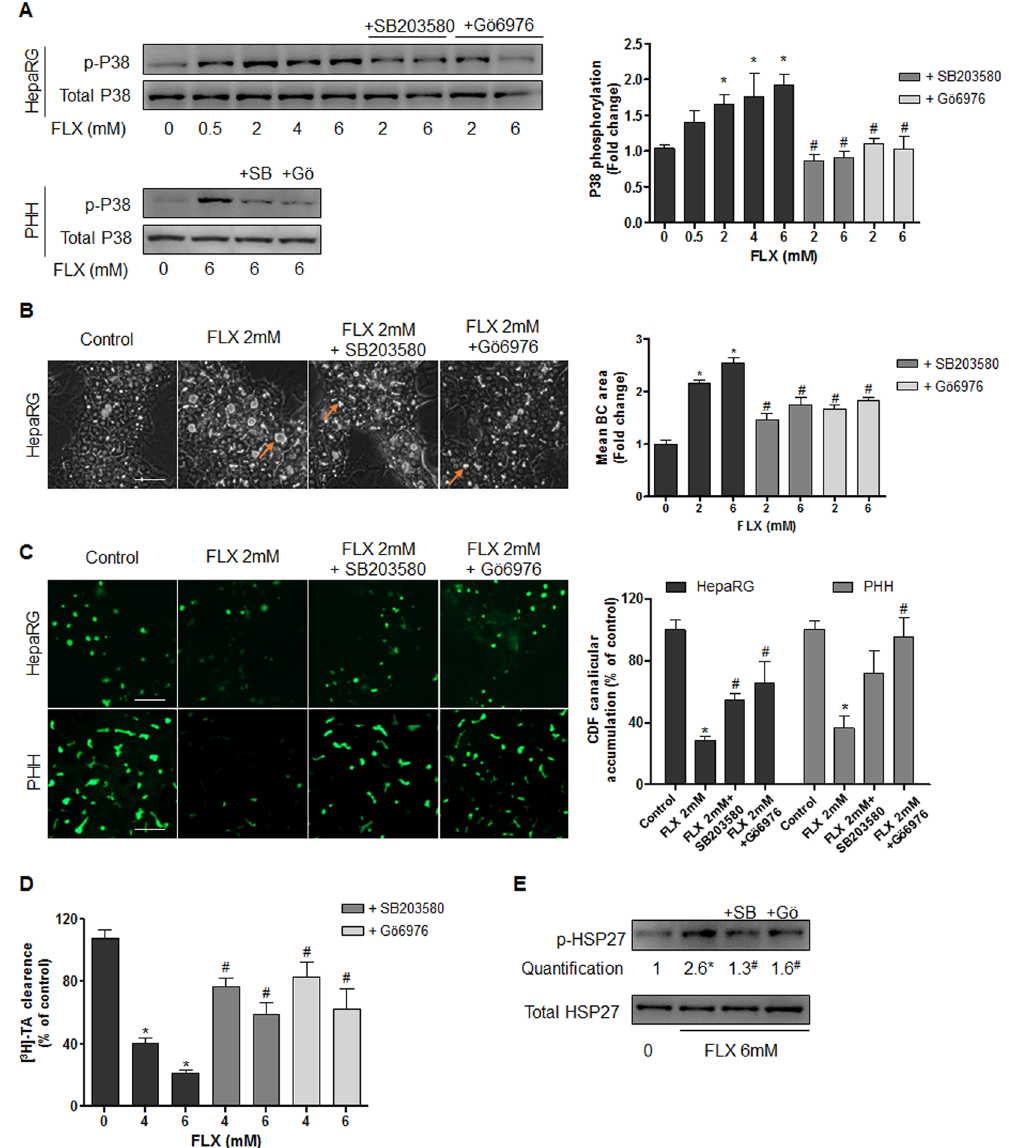
Figure 6. Involvement of PKC/P38 pathway in FLX-induced effects. ( A ) Representative western blots of the p-P38/total P38 forms after 2h-treatment with FLX (0–6 mM) alone or combined with 20 µ M PKC inhibitor (Gö6976; Gö) or 10 µ M P38 inhibitor (SB203580; SB) in HepaRG cells and PHH. Quantification of p-P38 in HepaRG cells using ImageJ 1.48 software. The displayed blots were cropped and the original full-length gels are included in the supplementary information. ( B ) Representative phase-contrast images of HepaRG cells treated with 2 mM FLX alone or combined with 20 µ M Gö6976 or 10 µ M SB203580. Quantification of BC area using ImageJ 1.48 software. Orange arrows indicating BC deformation (bar = 50 μ m). ( C ) CDF efflux in HepaRG hepatocytes and PHH treated 2 h with 2 mM FLX alone or combined with 20 µ M Gö6976 or 10 µ M SB203580. Quantification of CDF accumulation in BC of HepaRG hepatocytes and PHH, using ImageJ 1.48 software. ( D ) [ 3 H]-TA clearance in HepaRG cells treated with 4 or 6 mM FLX alone or co-treated with 20 µ M Gö6976 or 10 µ M SB203580 for 2 h. ( E ) Representative western blots of p-HSP27/total HSP27 forms after 2h-treatment with 6 mM FLX alone or combined with 10 µ M P38 inhibitor (SB203580; SB) or 20 µ M PKC inhibitor (Gö6976; Gö). Data were expressed relative to those of untreated cells arbitrarily set at 1 or 100%. They represent the means ± SEM of 3 independent experiments. * p < 0.05 compared with that of untreated cells, # p < 0.05 compared with that of cultures treated with FLX